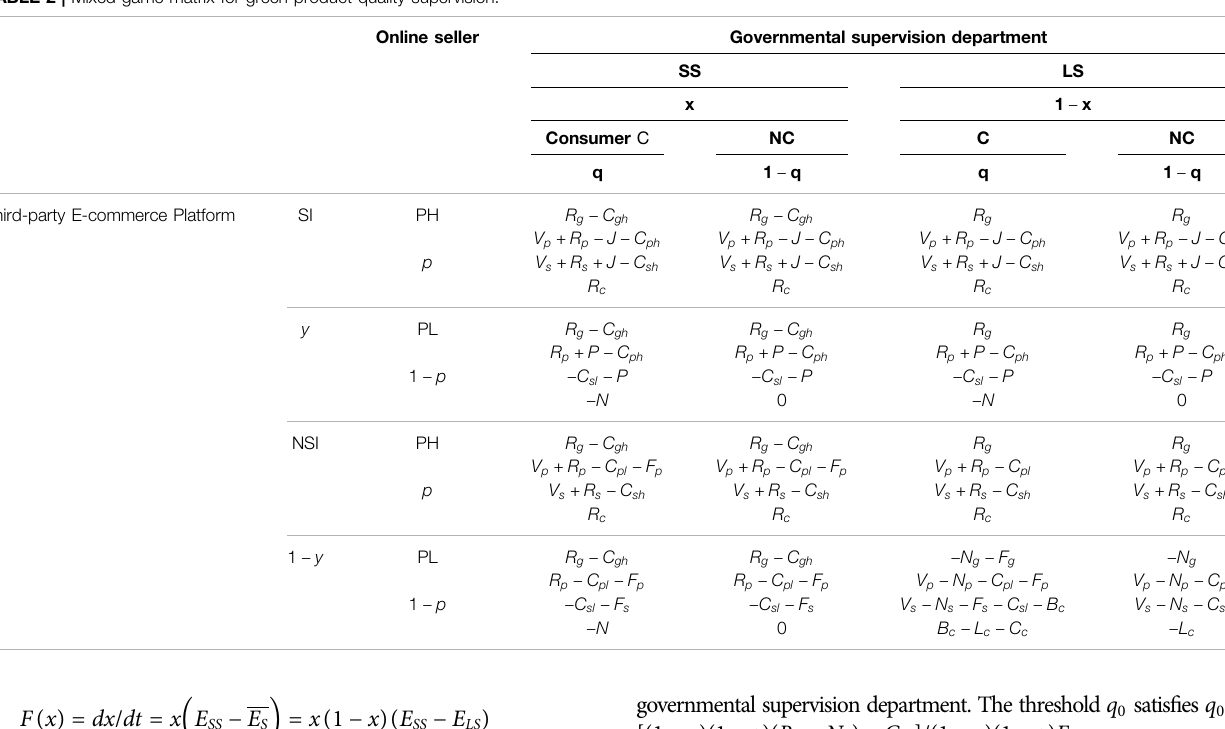
TABLE 2 | Mixed game matrix for green product quality